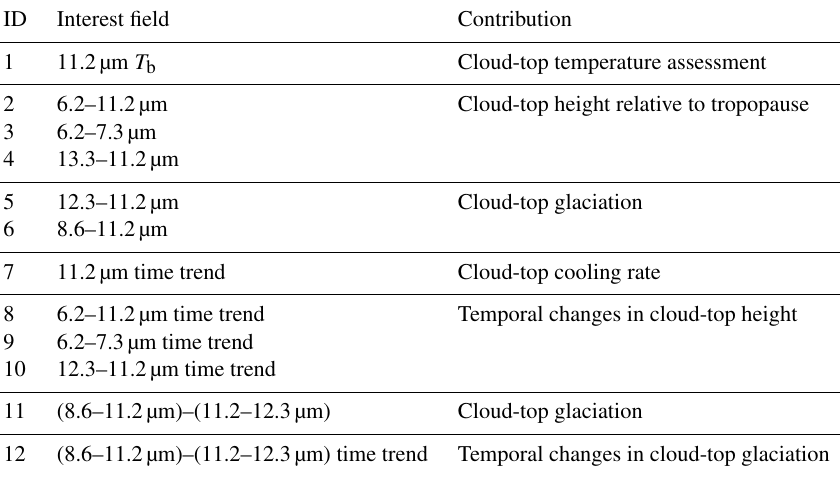
Table 3. Summary of the interest fields to develop convective initiation (CI) detection models used in this study (Walker and Mecikalski,